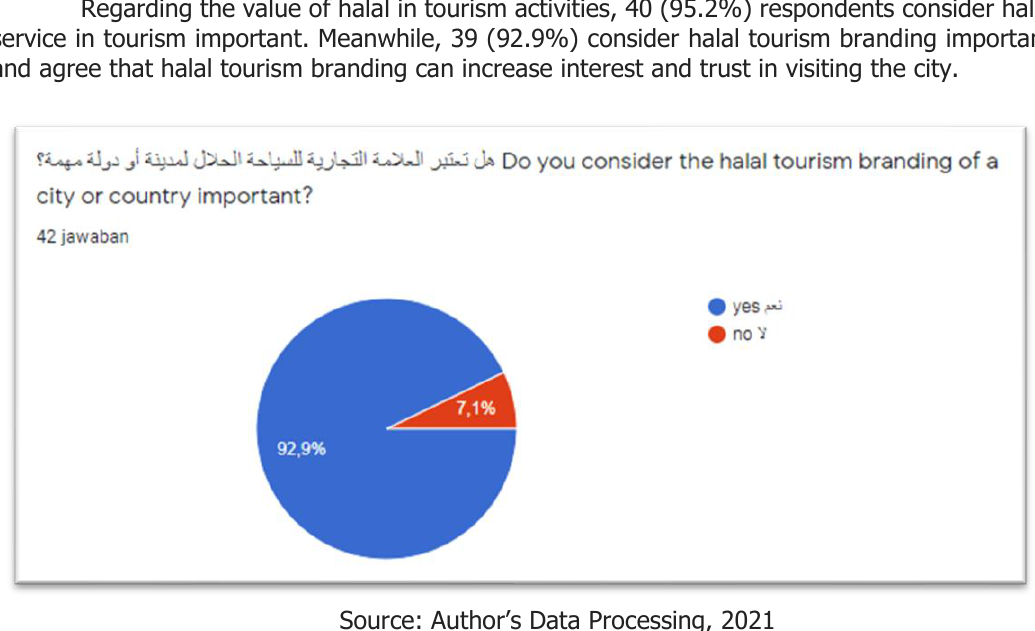
Figure 2. Response upon the importance of halal tourism branding of a